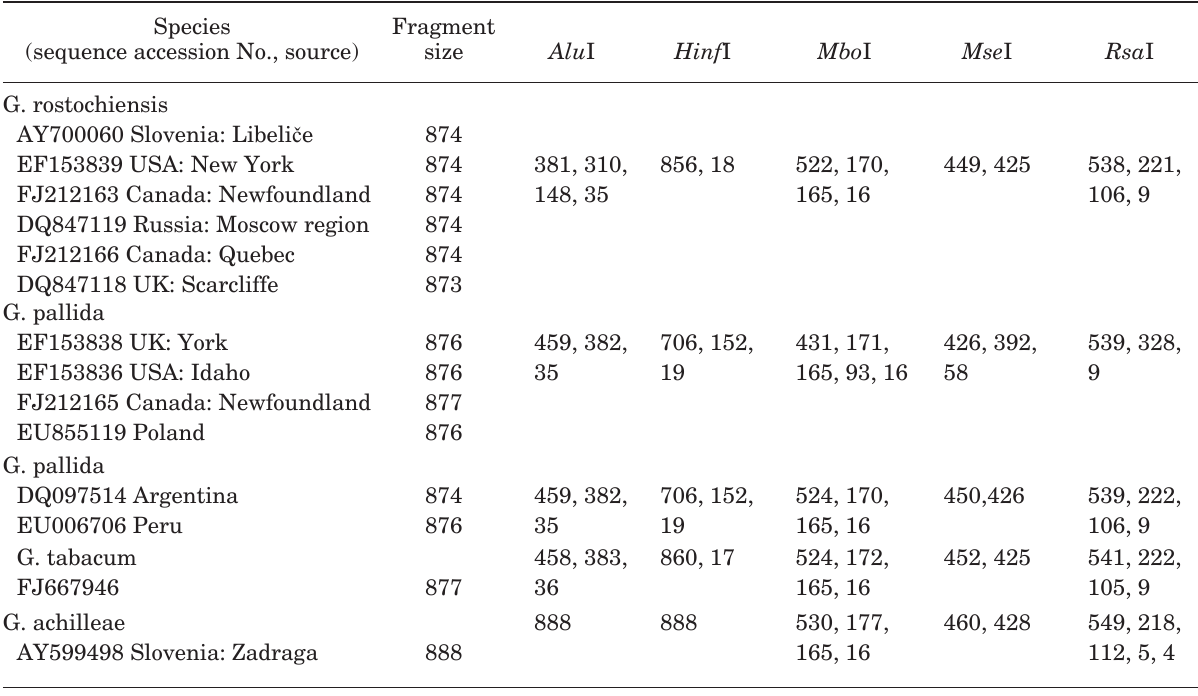
Table 4. In silico cleavage and fragment sizes of Globodera rostochiensis, G. pallida, G. tabacum and G. achilleae rDNA-ITS sequences with Alu l, Hinf l, Mbo l, Mse l and Rsa l. Species (sequence accession No.,